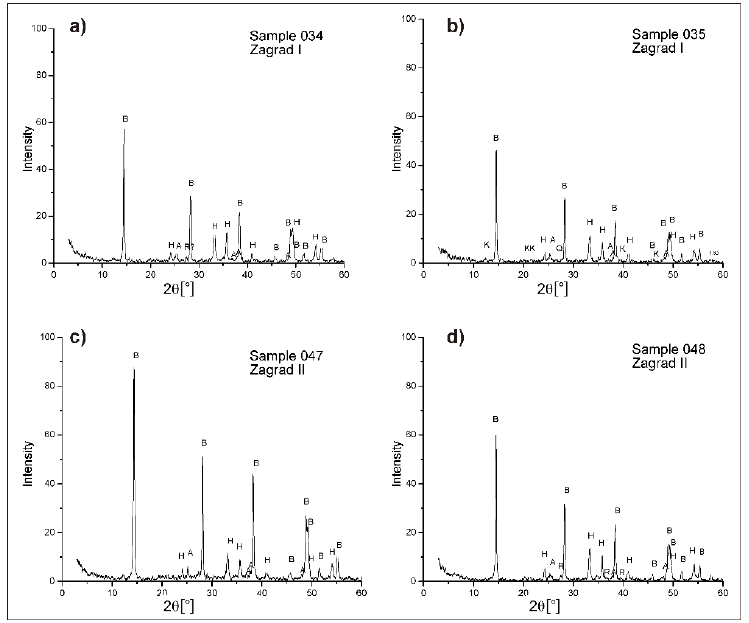
Figure 8. XRD patterns of four typical analysed sample from Zagrad deposit, ore body 3 (B—böhmite;